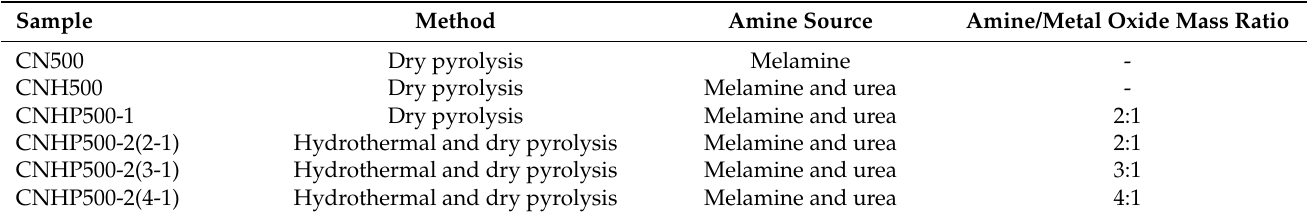
Table 3. Summary of the samples prepared in the